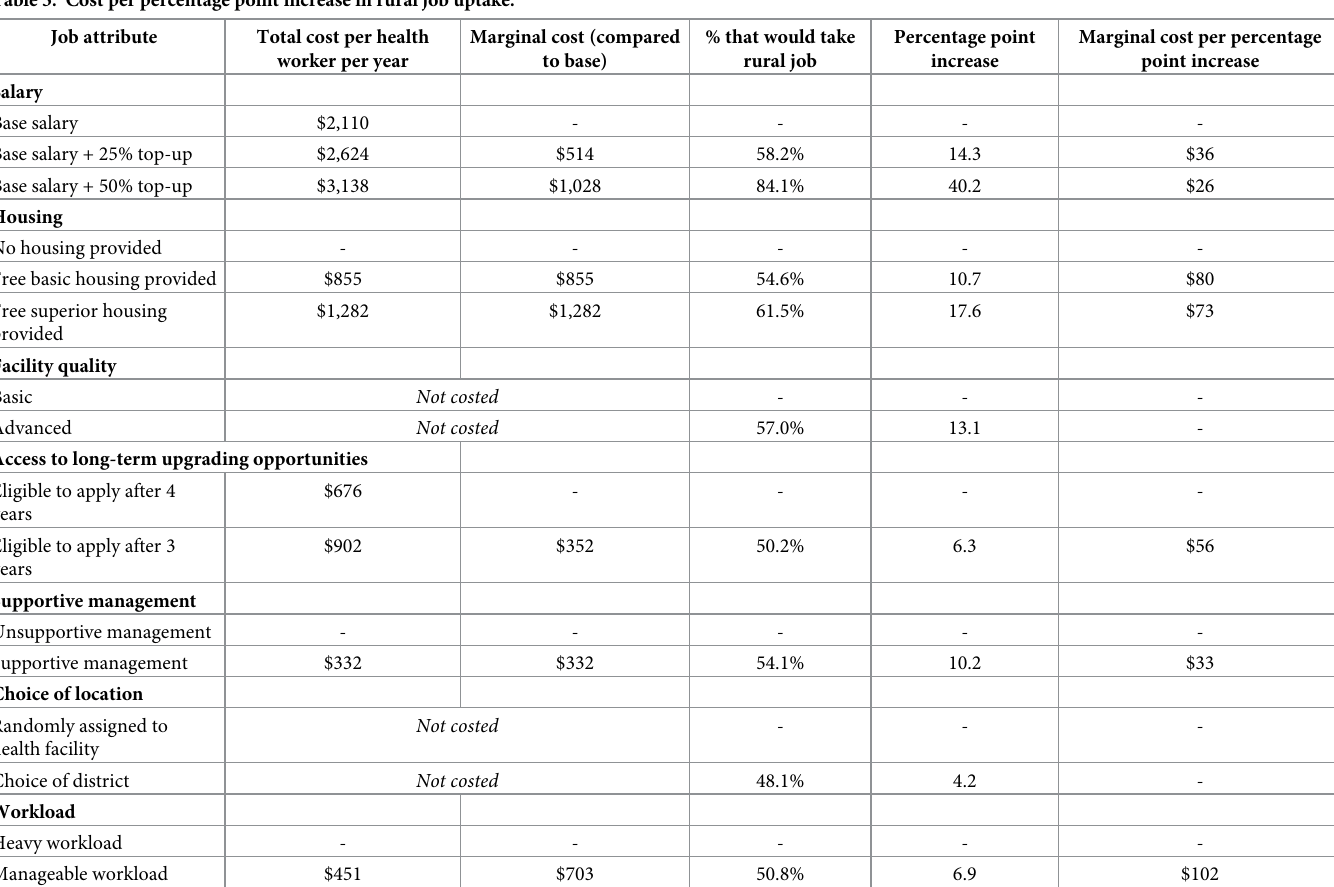
Table 5. Cost per percentage point increase in rural job